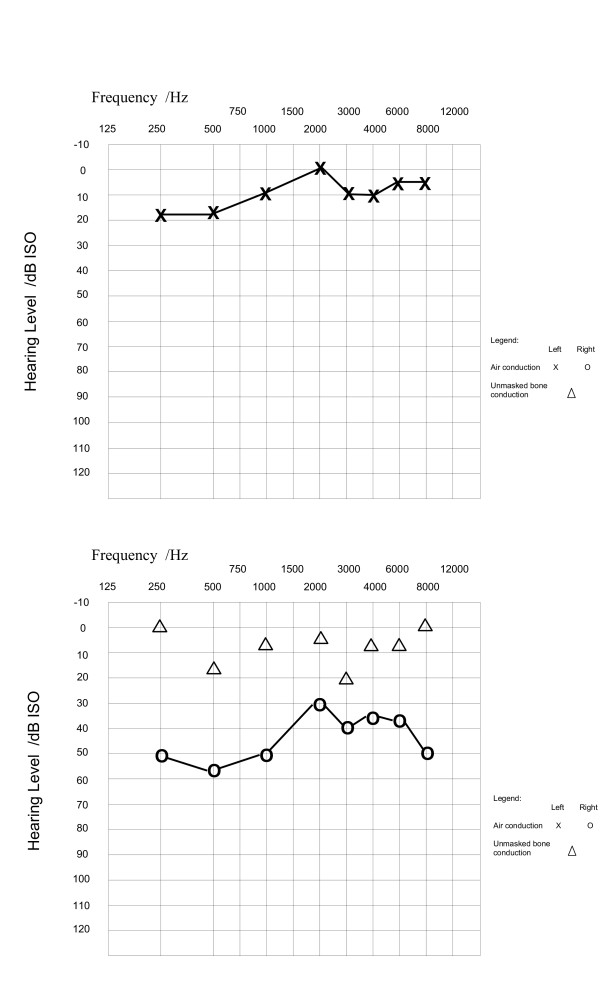
Pre-operative pure tone audiogram.